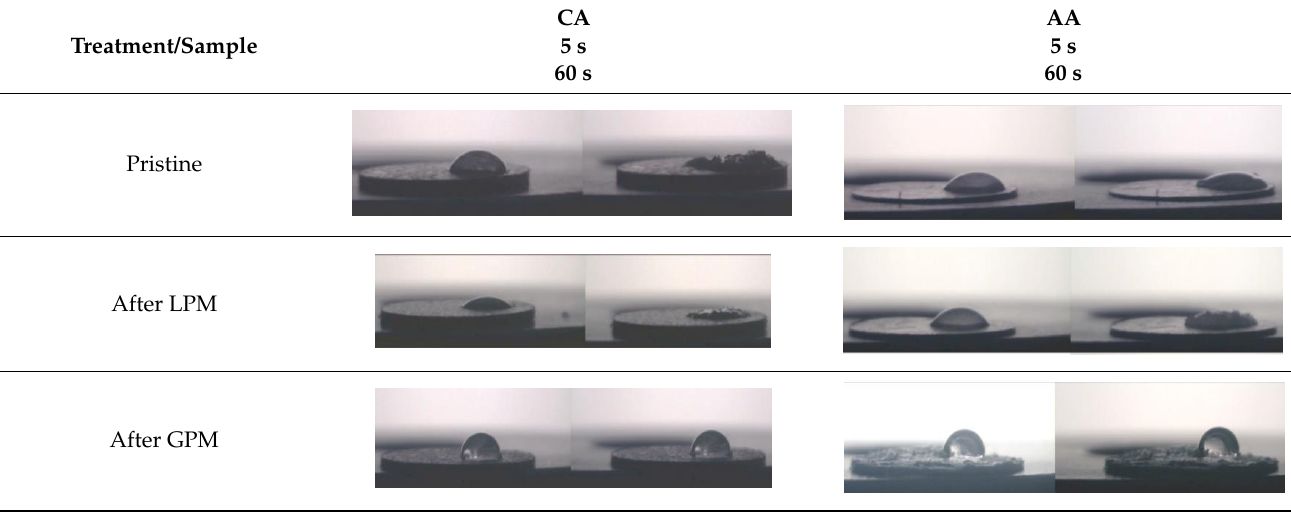
Table 4. Contact angle θ for pristine aerogels and a fter silanization in liquid phase (LPM) and in gas